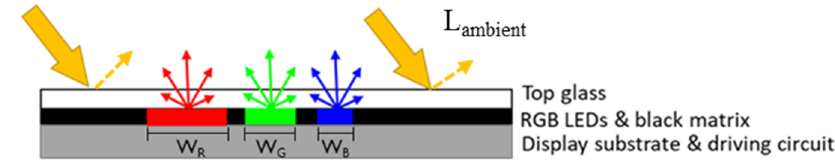
Figure 1. Device structure of our proposed RGB micro-LED display.